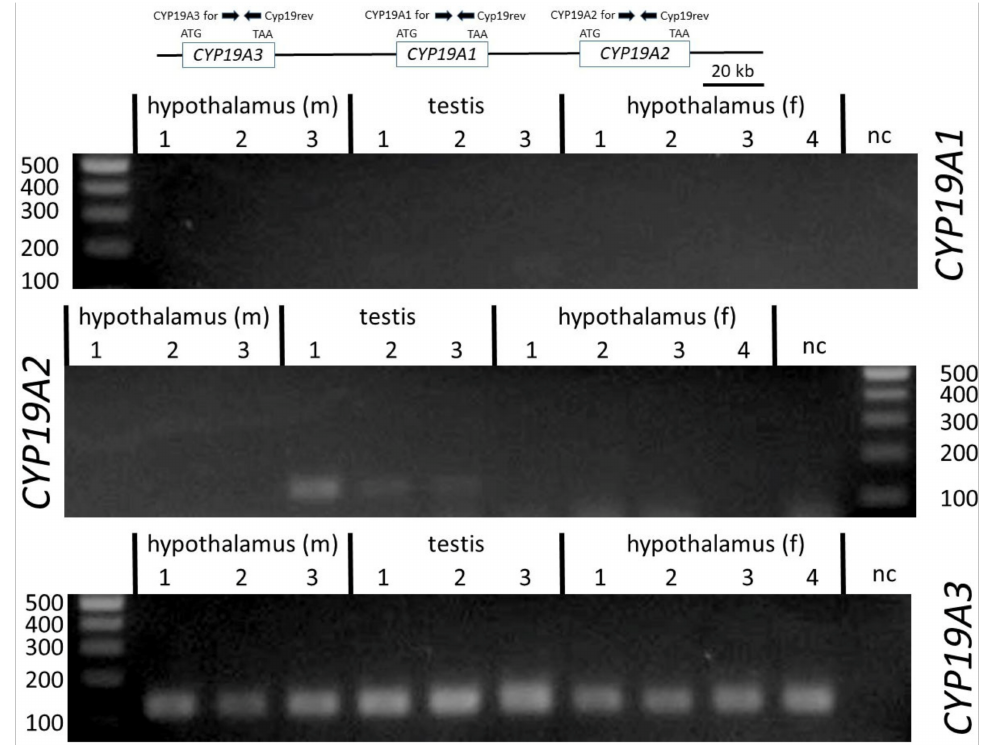
Figure 3. PCR products amplified with specific primers annealing to coding exons of CYP19A1 , CYP19A2 and CYP19A3 . Only transcripts from CYP19A3 were found in testis and in female and male hypothalamus from three to four individuals. CYP19A1 transcripts were not found in any of the samples, and only a weak band of CYP19A2 was amplified in testis of one boar (#1). Annealing positions of the respective primers are indicated in the inserted figure. f, m = female, male. Sizes of respective markers in base pairs are indicated.